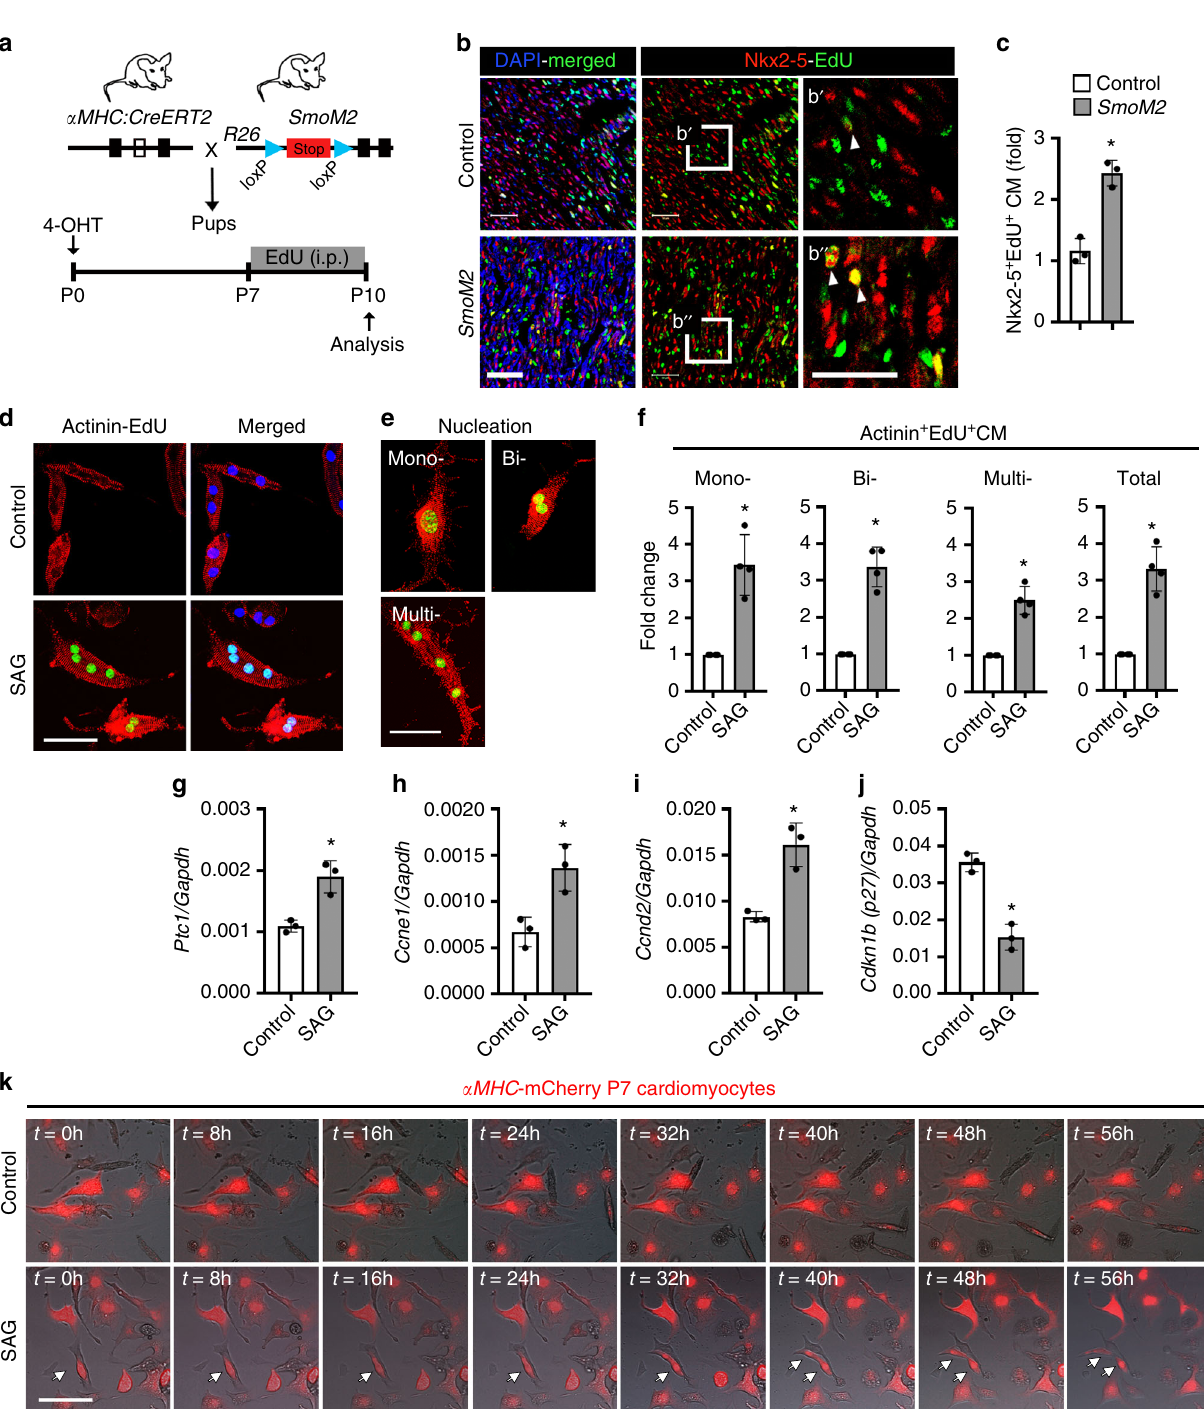
Fig. 4 Activation of HH signaling promotes cardiomyocyte proliferation during the non-regenerative period. a Schematic for the activation of HH signaling and EdU labeling in the postnatal heart during the non-regenerative window (P7-P10). b , c Immunostaining ( b ) and quanti fi cation ( c ) of Nkx2-5 + -EdU + cardiomyocytes in control and SmoM2 hearts. The boxed region in panel b is magni fi ed in b ′ and b ″ panels. Arrowheads indicate EdU + cardiomyocytes. Quantitative analysis in panel c represents the counting of four random fi elds at 20× magni fi cation from three biological replicates. d – f Immunohistochemical images ( d , e ) and quanti fi cation ( f ) of α -Actinin + -EdU + cultured P7 cardiomyocytes from control- and SAG-treated conditions. Quantitative analysis represents the counting of three random fi elds from four replicates ( n = 2100 cardiomyocytes for each condition). Representative images and quanti fi cation of the number of mono-, bi-, multi-nucleated and total myocytes from control- and SAG-treated samples are shown. g – j qPCR analysis of Ptc1 , Ccnd2 , Ccne1, and Cdkn1b (p27) transcripts using RNA isolated from control- and SAG-treated P7 cardiomyocytes ( n = 3). k Time-lapse microscopic images of α MHC-mCherry + cardiomyocytes from control- and SAG-treated conditions at the speci fi ed time intervals. The white arrow indicates the dividing cardiomyocyte. Data are presented as mean ± SEM ( n = 3; * p < 0.05) (see also Supplementary Fig. 5) and scale bars = 100 μ m. Statistical tests were done using two-tailed unpaired Student ’ s t